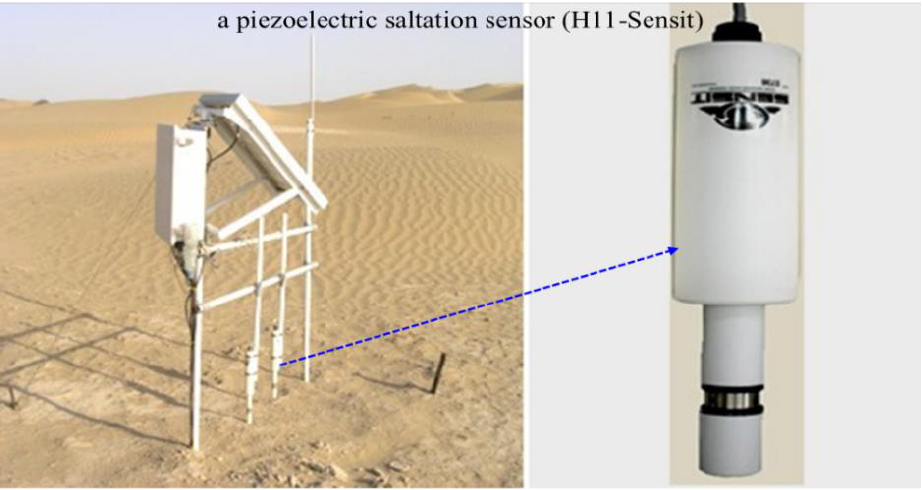
Figure 3. Wind erosion sensor (H11-Sensit).